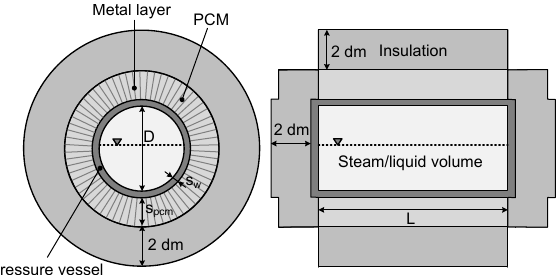
Figure 1. Simplified hybrid storage vessel